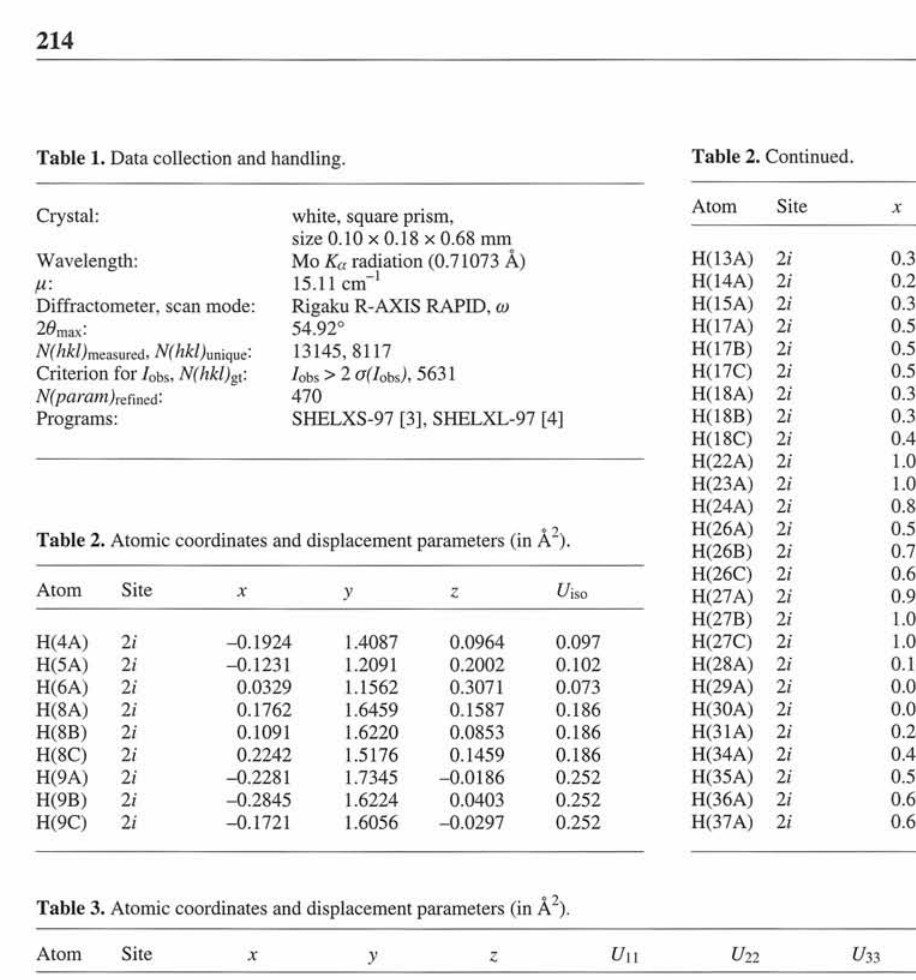
Table 3. Atomic coordinates and displacement parameters (in Â 2